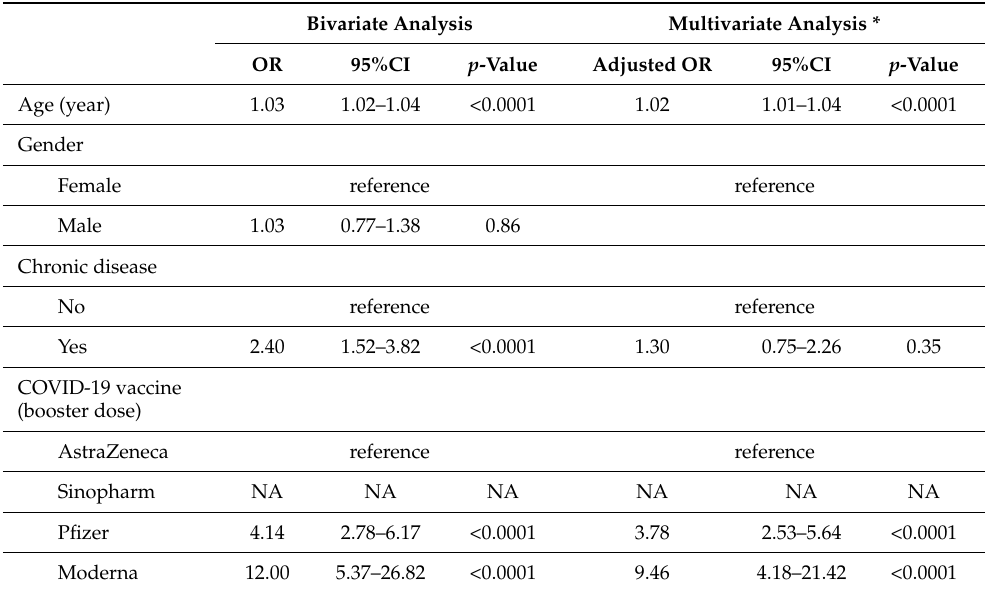
Table 4. Factors associated with the severity of side effects after receiving booster dose versus first and second doses of COVID-19